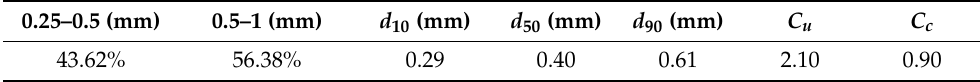
Table 1. Coral sand particle grading index.